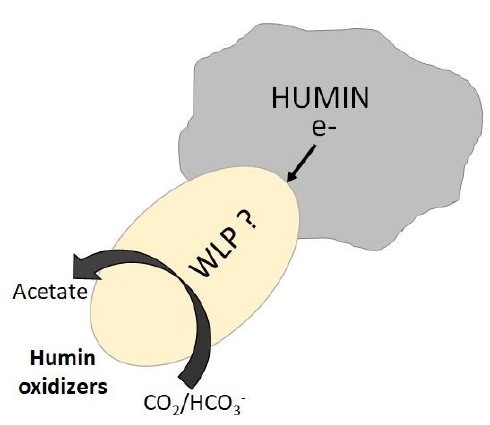
Figure 5. Microbial CO 2 -reducing acetogenesis supported by humin as EEM for the electron donation to the consortium PCPA0 in the CO 2 / HCO 3- -bu ff ered